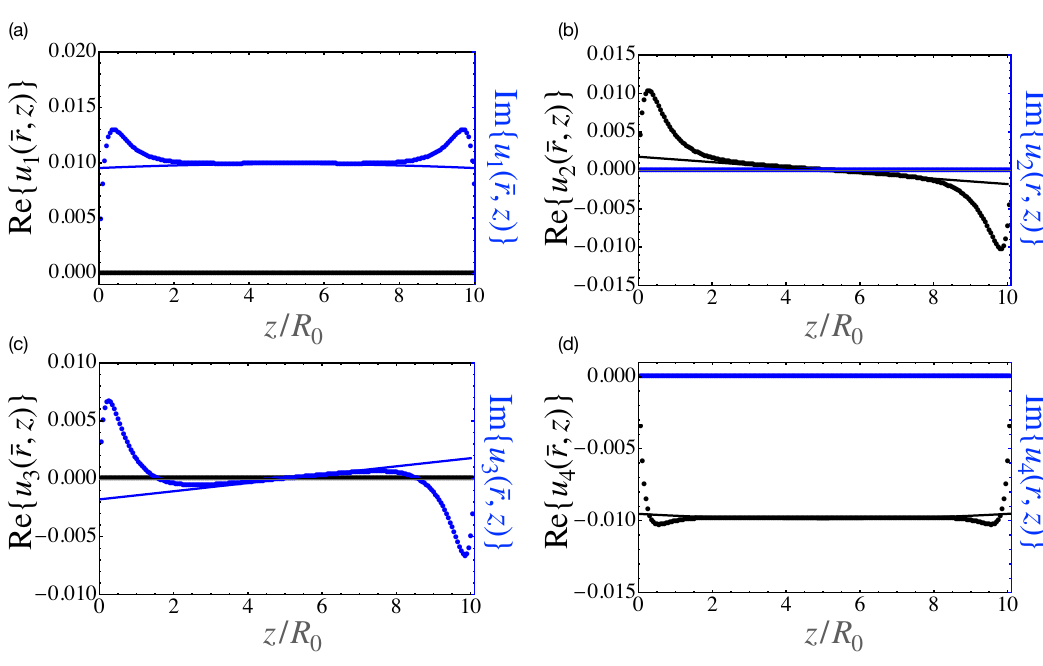
Figure 5: The four components of the wavefunctions u (with i = 1,...,4), defined in i Eq. (3), are plotted as functions of z for the quantum numbers n = 1 and j = 1 / 2. The four panels (a), ..., (d) refer to the components 1, ...,4, respectively. They are calculated for a nanocylinder with R = 30 R and L = 10 R at a fixed r = ¯ r , which 0 0 approximatively corresponds to the position of the peak of the probability density on the side of the cylinder. Solid lines are obtained through the approximated analyt- ical model, while the filled circles are the result of the exact numerical model ob- tained by means of the numerical tight-binding model with discretisation constants = 0.25 R = 0.05 R a and a r z 0 0